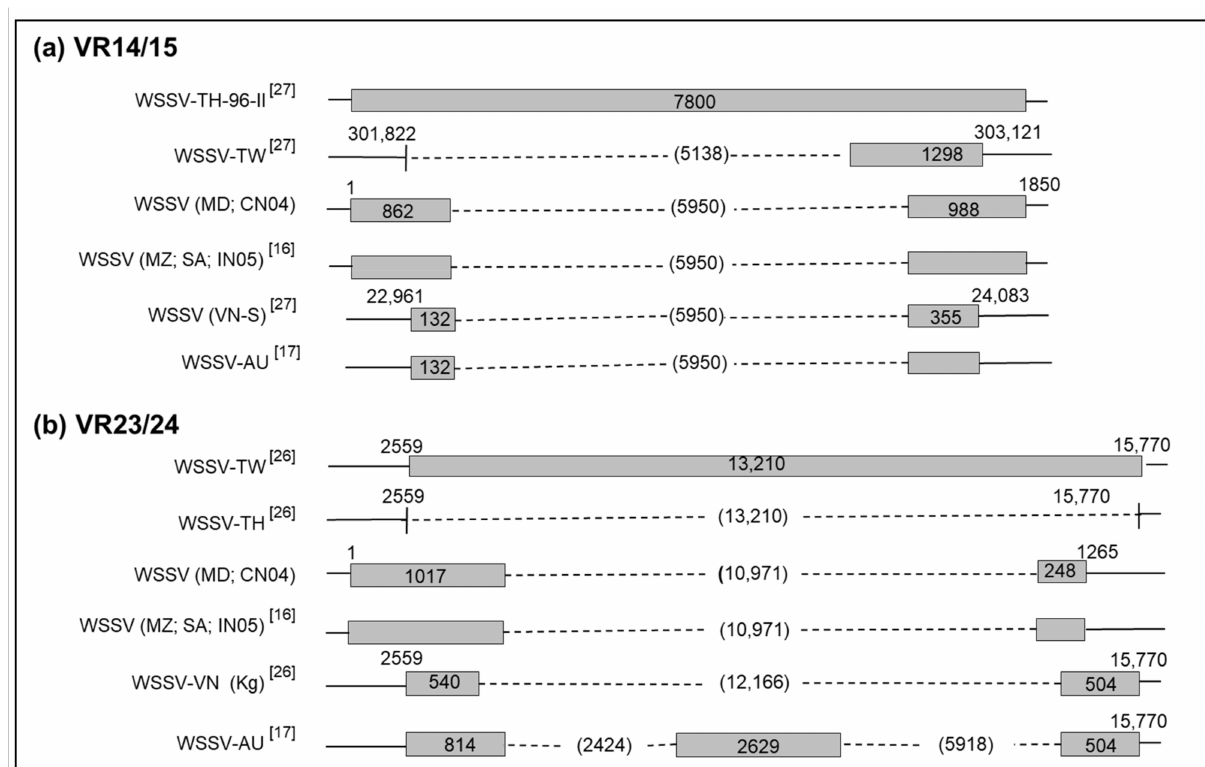
Figure 2. Schematic representation of the variable regions VR14/15 ( a ) and VR23/24 ( b ). Fragment lengths (bp) are described in boxes. Nucleotide position numbers in 5 (cid:48) and 3 (cid:48) regions are indicated above each strain according to GenBank sequences. Dashed lines indicate the deleted sequences. Deletion size is given in brackets. MD: Madagascar, MZ: Mozambique, SA: Saudi-Arabia, TH: Thaïland, TW: Taïwan, CN: China, VN: Vietnam, IN: India, AU: Australia (GenBank Accession